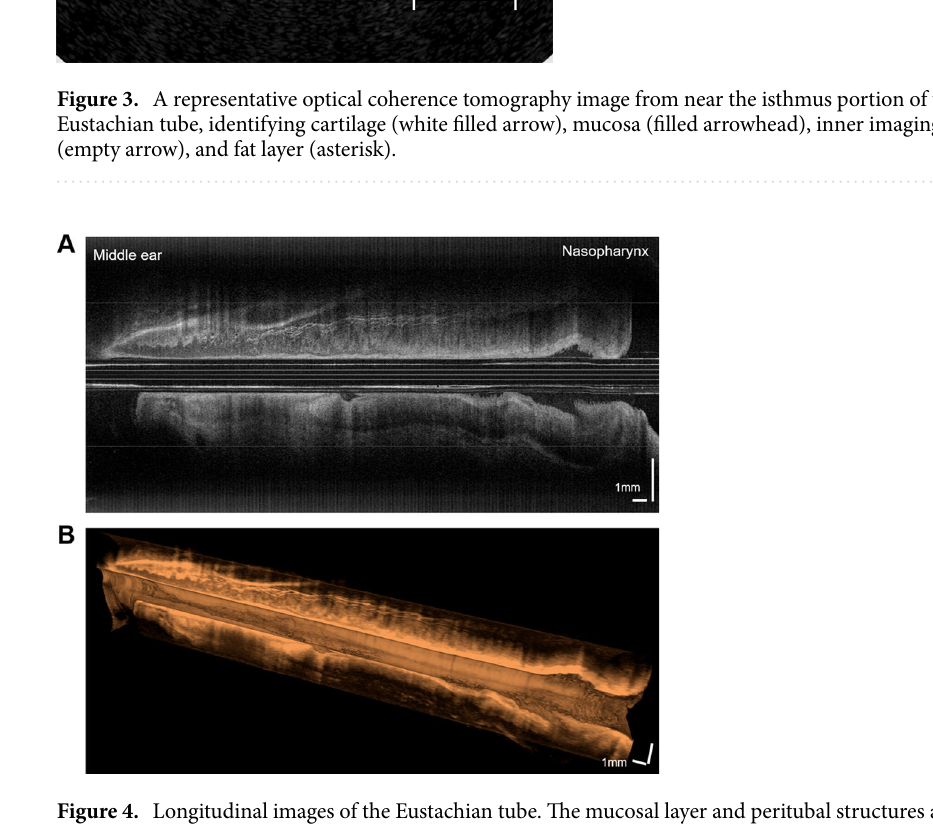
Figure 4. Longitudinal images of the Eustachian tube. The mucosal layer and peritubal structures are shown for the entire length of the tube ( A ). A 3D cut-away longitudinal image reveals the surface lining of the Eustachian tube ( B